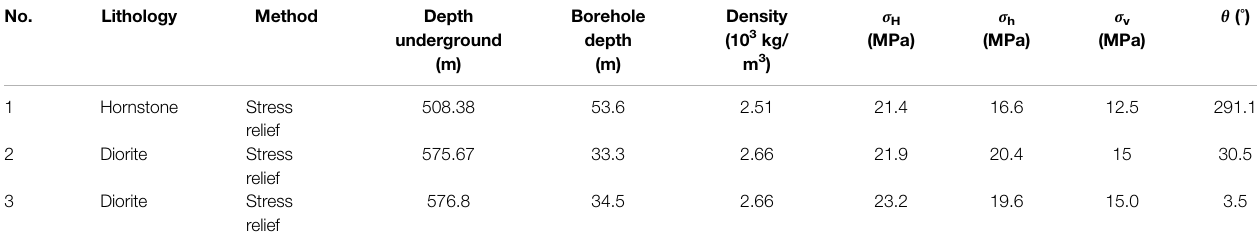
TABLE 2 | In situ ground stress levels (December 2019). The principal stress is speci fi ed via three components: σ H (maximum horizontal stress), σ h (horizontal intermediate stress) and σ v (minimum vertical stress). The angle θ is the angle between the horizontal principal stress and north direction. No.